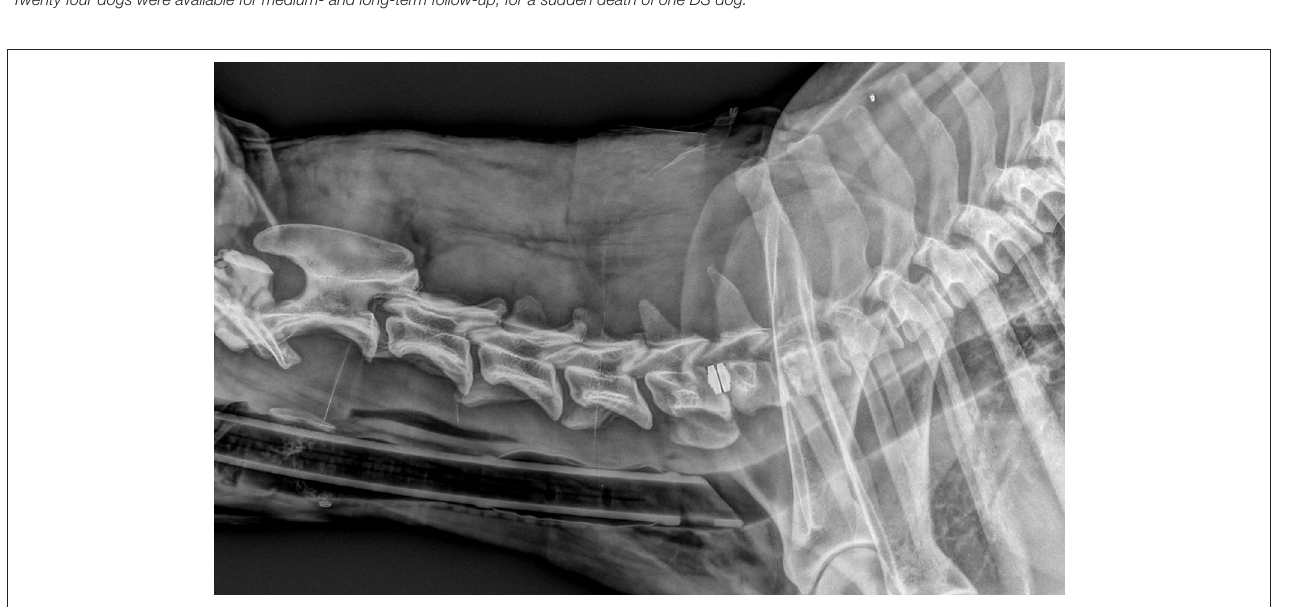
FIGURE 3 | Same dog as in Figure 1 , with severe neurological deterioration and subsidence at 9 days after